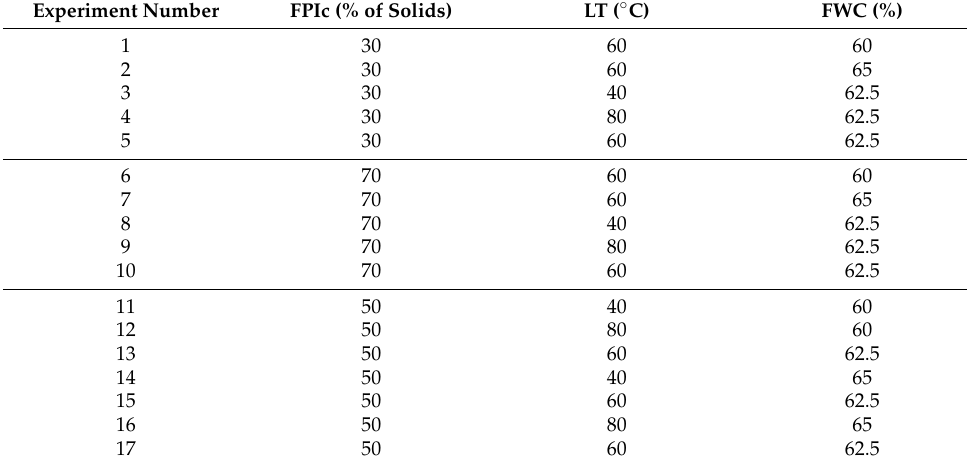
Table 2. Split-plot Box–Behnken experimental design used, including independent variables of faba bean protein isolate content (FPIc), long cooling die temperature (LT), and feed water content (FWC). Experiment